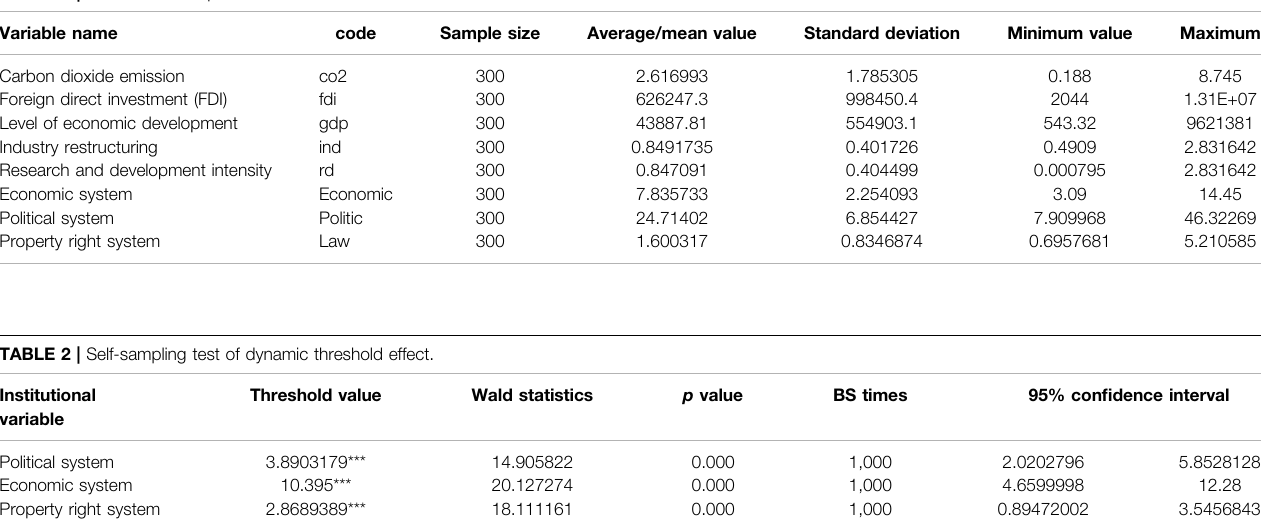
TABLE 1 | Statistical description of table variables.